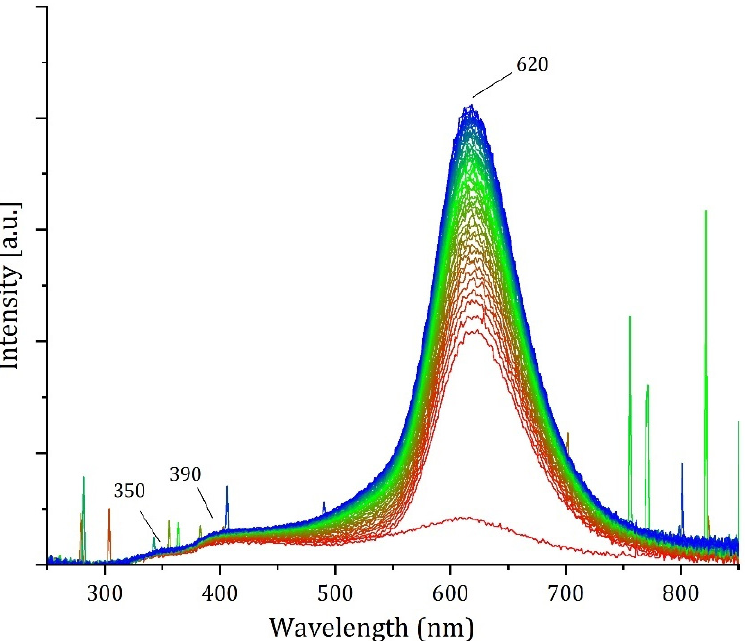
Figure 6. RL spectra of Q_LS under X-ray irradiation. Each spectrum corresponds to the total emitted light every 30 s (6 Gy per spectrum). The colour scale goes from red (first spectra), to green, to blue (last spectra).